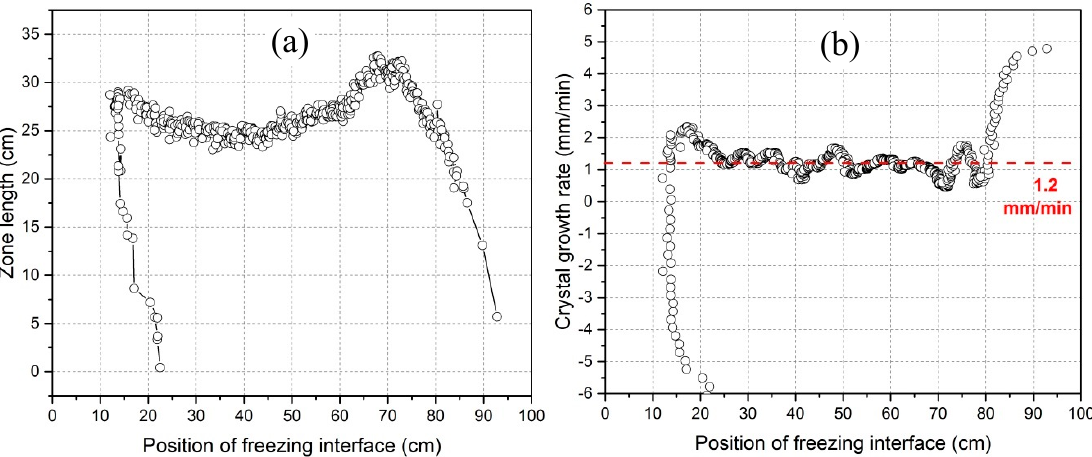
Figure 7. Zone length ( a ) and crystal growth rate ( b ) as a function of the position of the freezing interface.